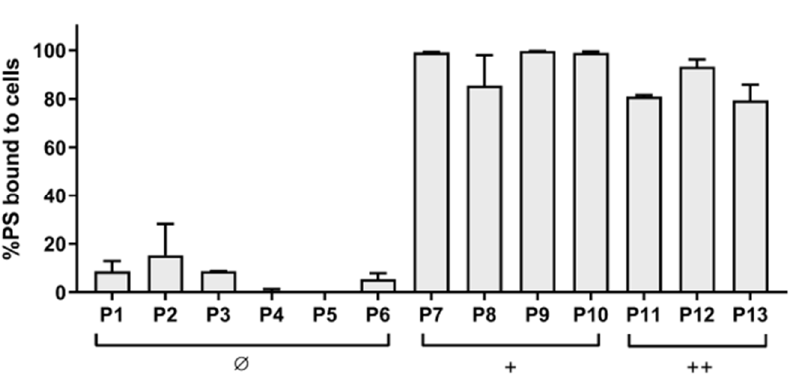
Figure 2. Binding assay of diaryl-porphyrins (P1–P13) to P. aeruginosa PAO1. Bacterial cells at 10 8 CFU/mL were dark incubated for 1 h with neutral (Ø), monocationic (+) and dicationic (++) porphyrins administered at a concentration of 30 µ M. Samples were centrifuged (10,000 × g , 5 min) and the visible spectra of the supernatants were recorded. The rate of bound PS was inferred. Three independent experiments have been performed and the mean ± standard deviation of percentage of PS bound to cells is reported for each diaryl-porphyrin.